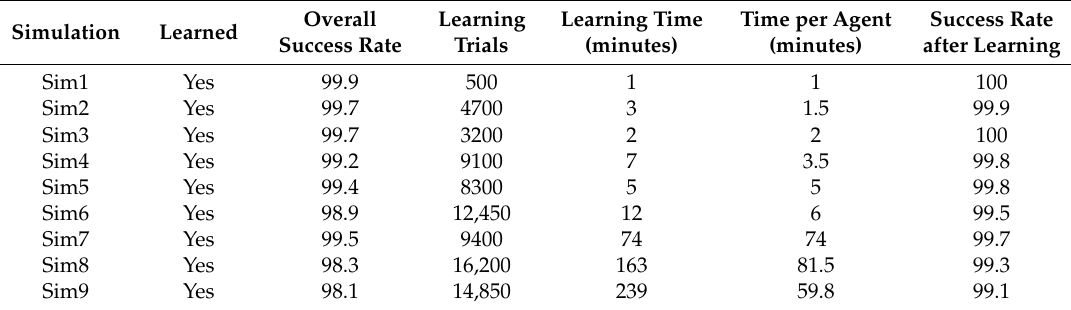
Table 5. Results for the proposed model in each of the simulations.